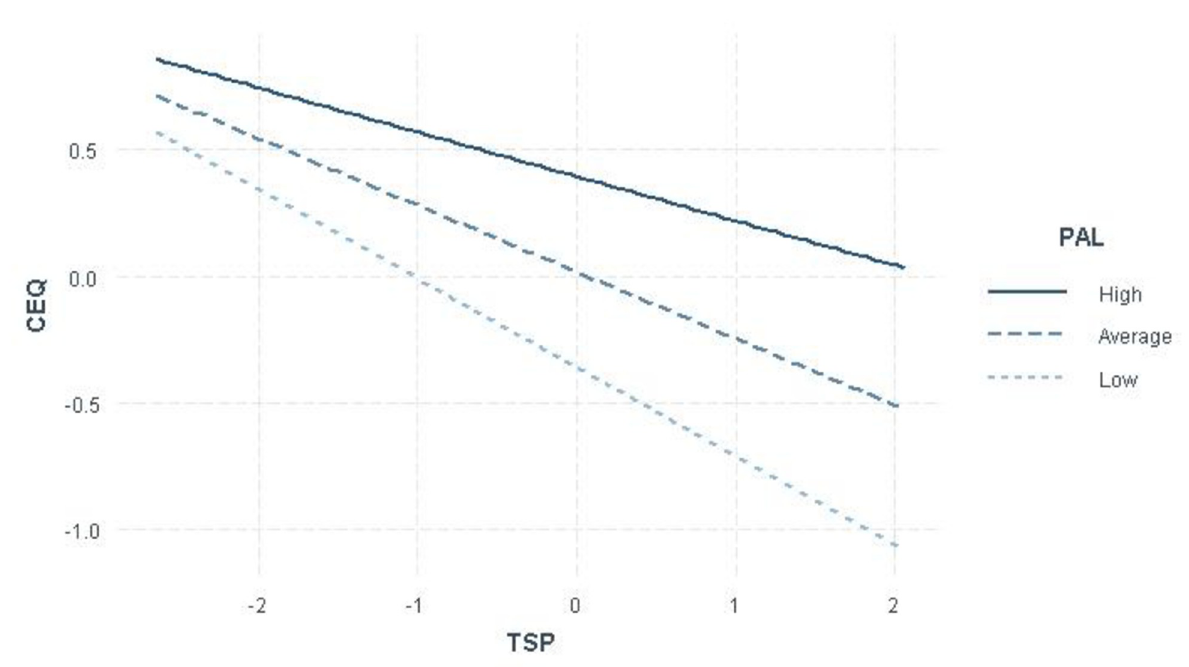
Fig 1. The effect of the interaction of access limitations. The figure represents the difference found in the relationship between teaching strategies and concerns about quality. TSAP = Teaching strategies adopted by the professor; PAL = Perception of access limitations.